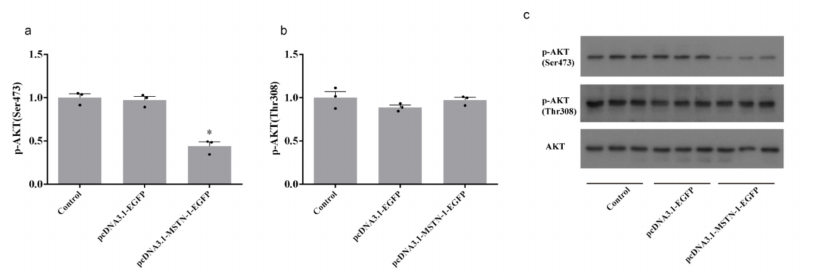
Figure 9. Overexpression of mstn-1 inhibits protein kinase B (AKT) signaling by decreasing the phosphorylation of AKT at Ser473. ( a ) Western blot analysis of the phosphorylation level of AKT at Ser473. Histograms represent the ratio between the phosphorylated AKT at Ser473 and the total amount of AKT and ( b ) Western blot analysis of the phosphorylation level of AKT at Thr308. Histograms represent the ratio between the phosphorylated AKT at Thr308 and the total amount of AKT. ( c ) E ff ect of mstn-1 overexpression on the protein expressions of phosphorylated protein kinase B (p-AKT) (Ser473), p-AKT (Thr308), and AKT. Results are represented as mean ± SE ( n = 3). * means significantly di ff erent compared with control ( p < 0.05).